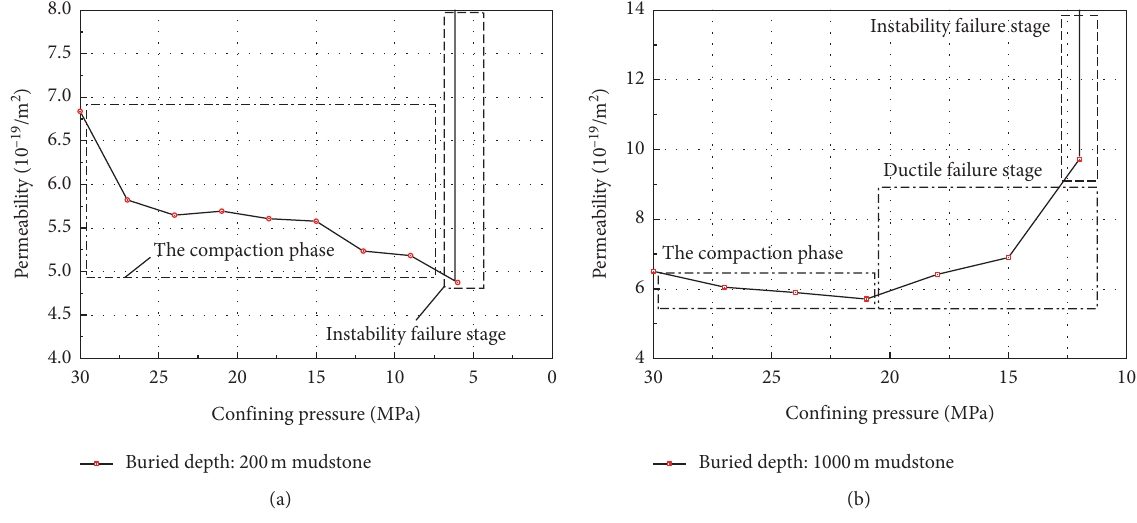
Figure 9: Mudstone permeability versus confining pressure. (a) Depth � 200m. (b) Depth � 1000m.